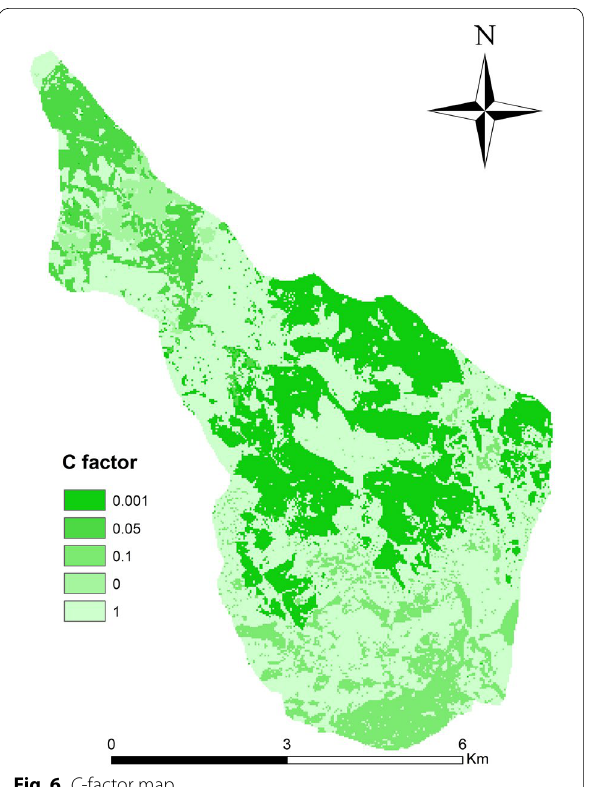
Fig. 7 Annual soil loss map of the Ikkour